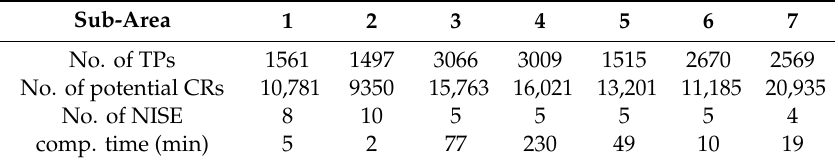
Table 10. Properties and computation times (minutes) for the sub-areas in the Gotschna